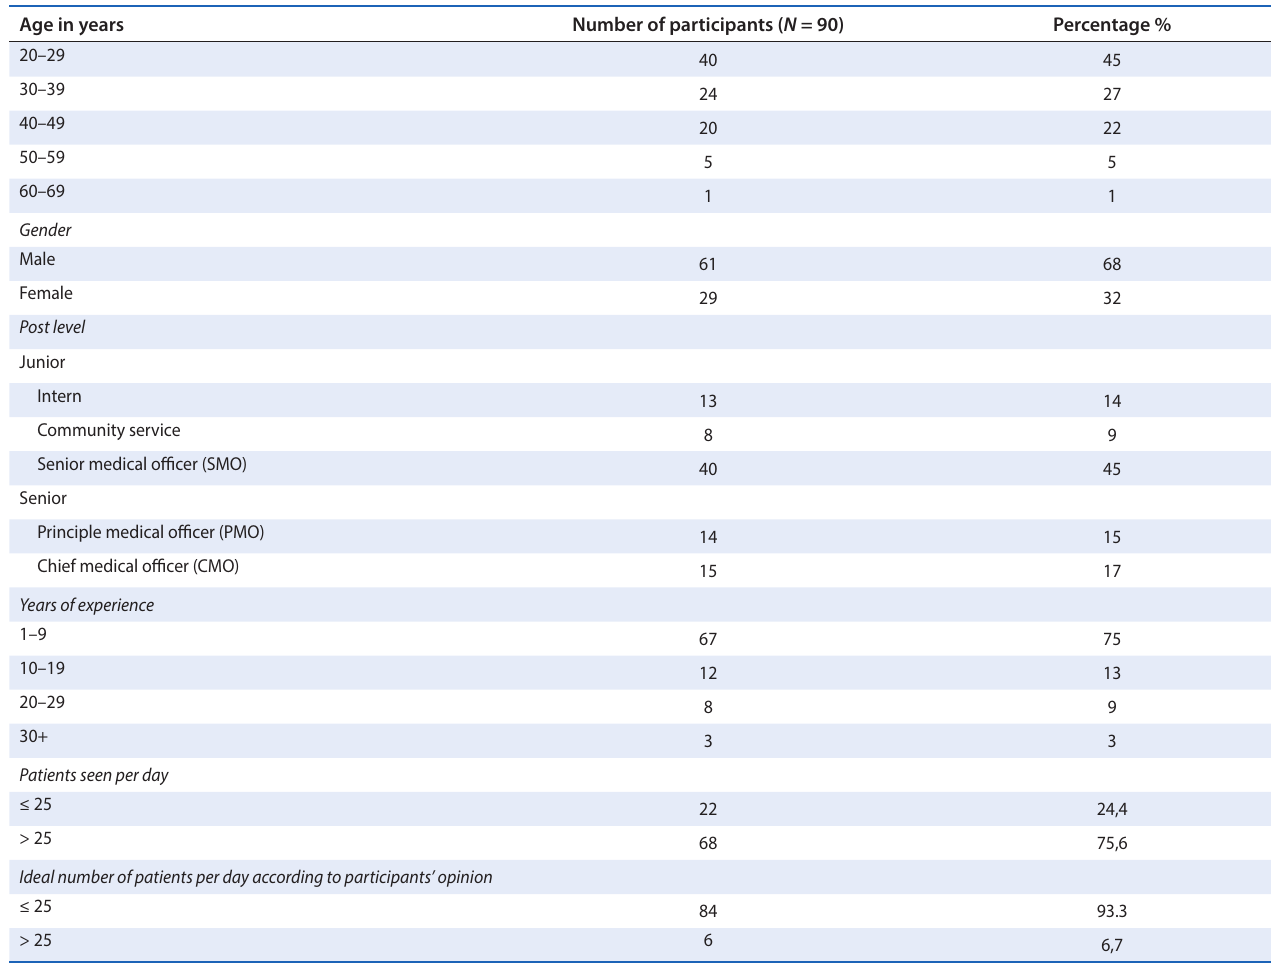
Table 1: Demographics of participants and their practices Age in